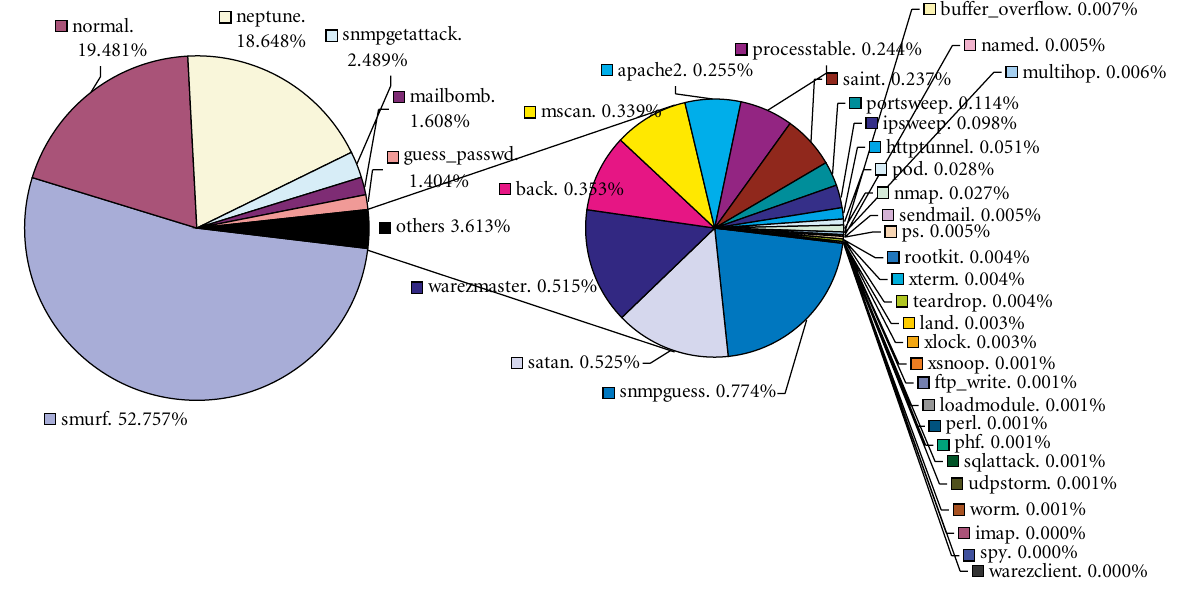
Figure 5: The data distribution of every attack type breakdown in the test set.